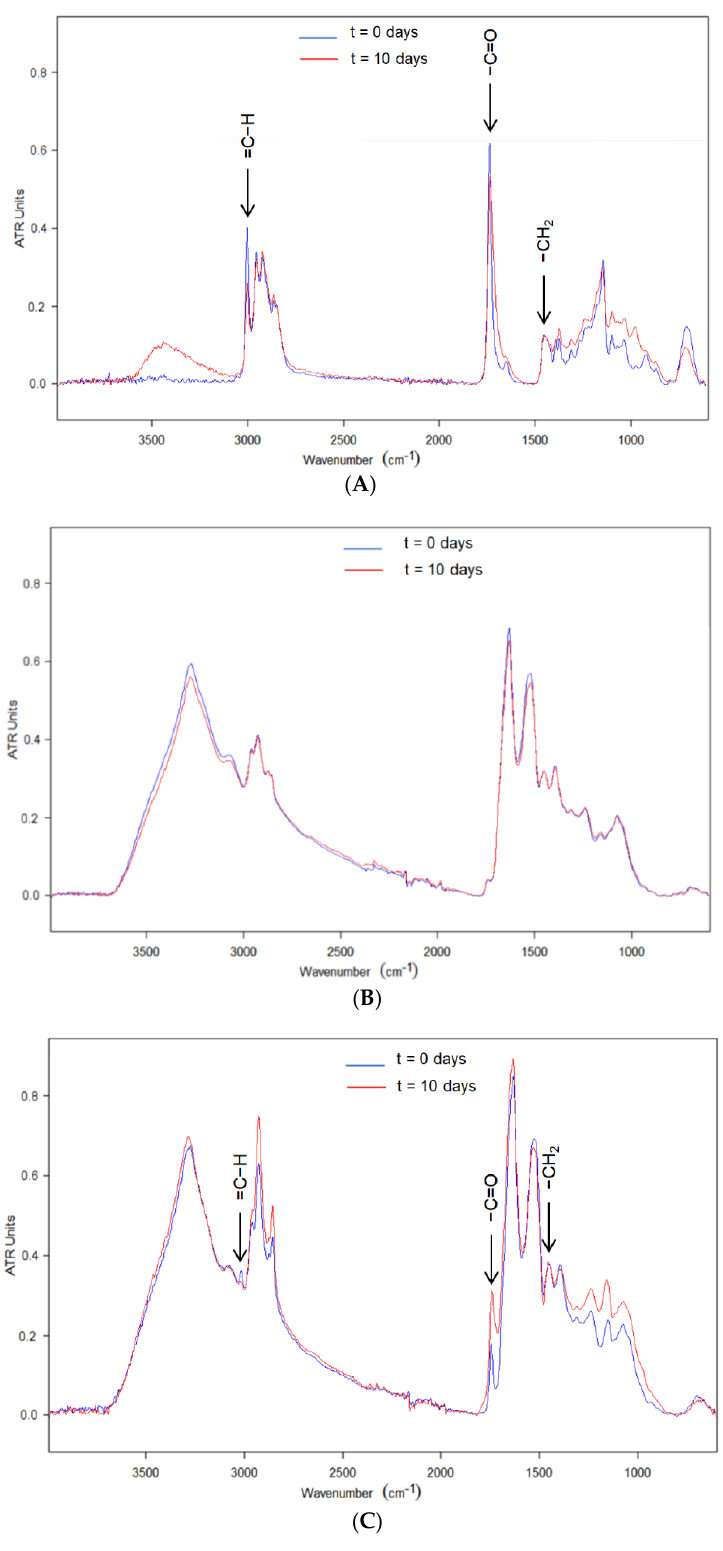
Figure 4. Evolution of the attenuated total reflection—Fourier transform infrared spectroscopy (ATR- FTIR) spectra during the accelerated oxidation test: ( A ) EPA-rich oil, ( B ) WPC and ( C ) WPC-EPA-rich oil